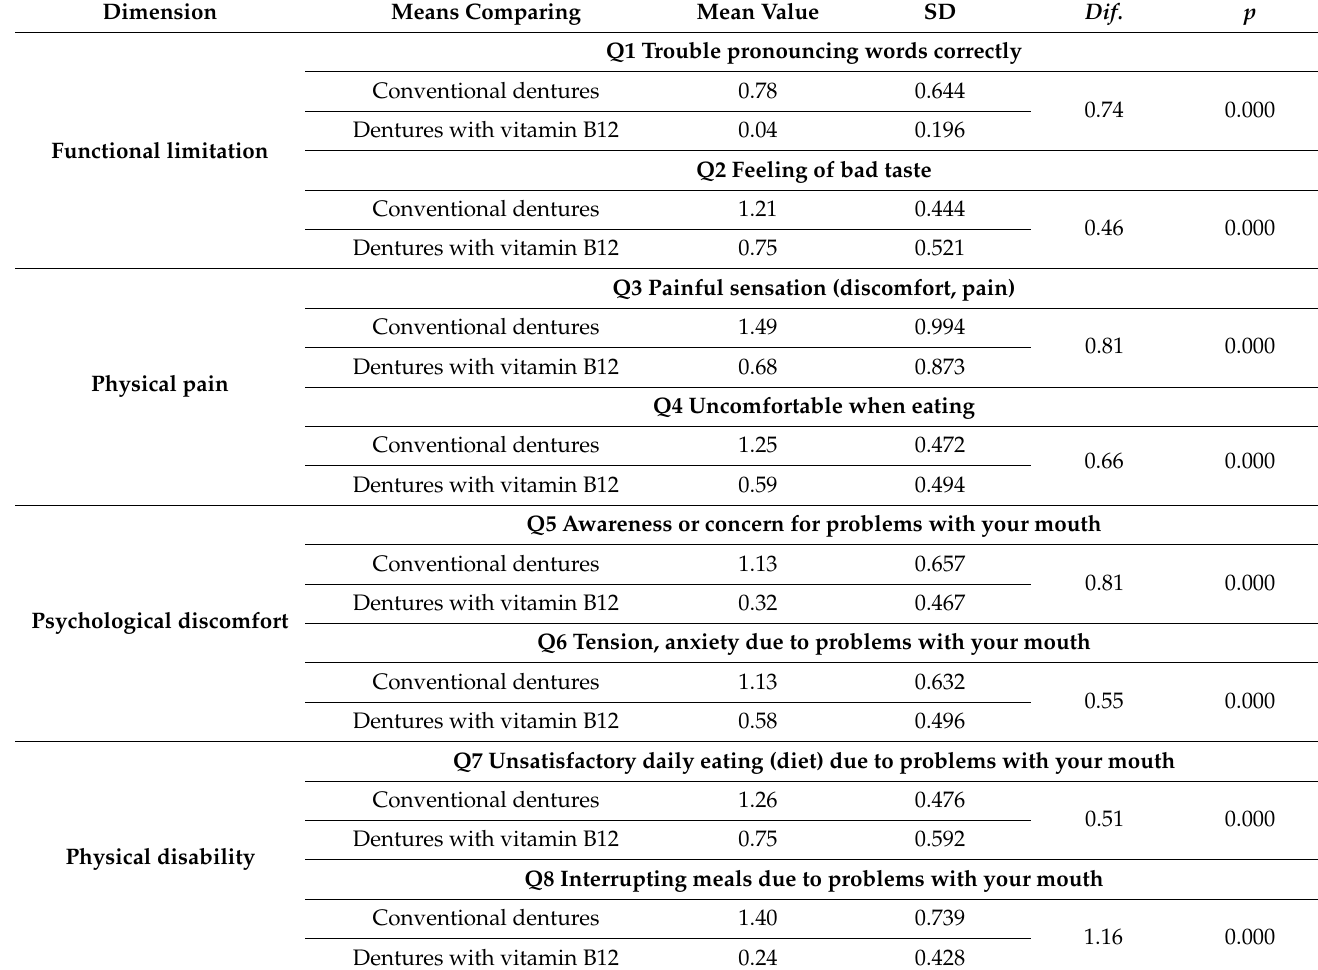
Table 5. The differences registered between the two groups for each dimension